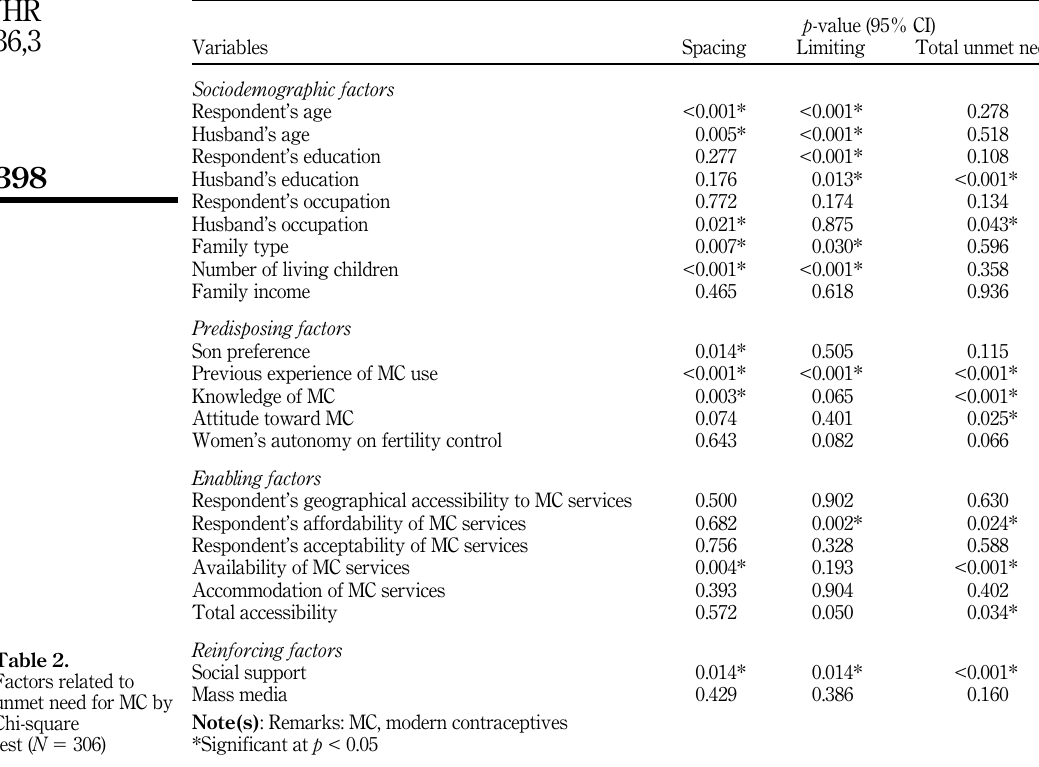
unmet need for MC by Chi-square test ( N 5